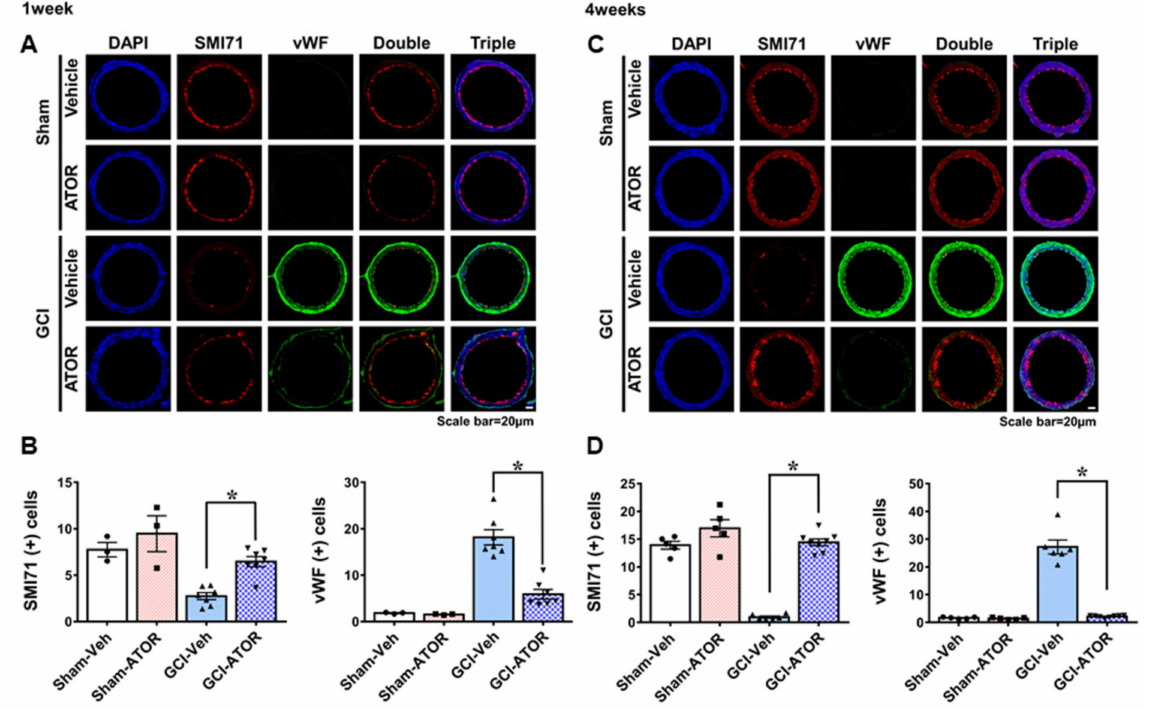
Figure 5. Atorvastatin prevents endothelial cell loss and vasa vasorum proliferation after global ischemia. Treatment with atorvastatin for 1-week after GCI decreased endothelial cell loss and restrained vasa vasorum proliferation ( A ). The 4-week atorvastatin treatment after GCI considerably reduced endothelial cell loss and significantly inhibited vasa vasorum proliferation ( C ). Scatter dot plot bar graphs showing the quantification of endothelial cells and vWF levels at 1 and 4 weeks ( B , D , respectively). Data are mean ± S.E.M.; for both acute and chronic model, n = 3–5 for each sham group, n = 6–8 for each ischemia group. * Significantly different from the vehicle-treated group, * p <